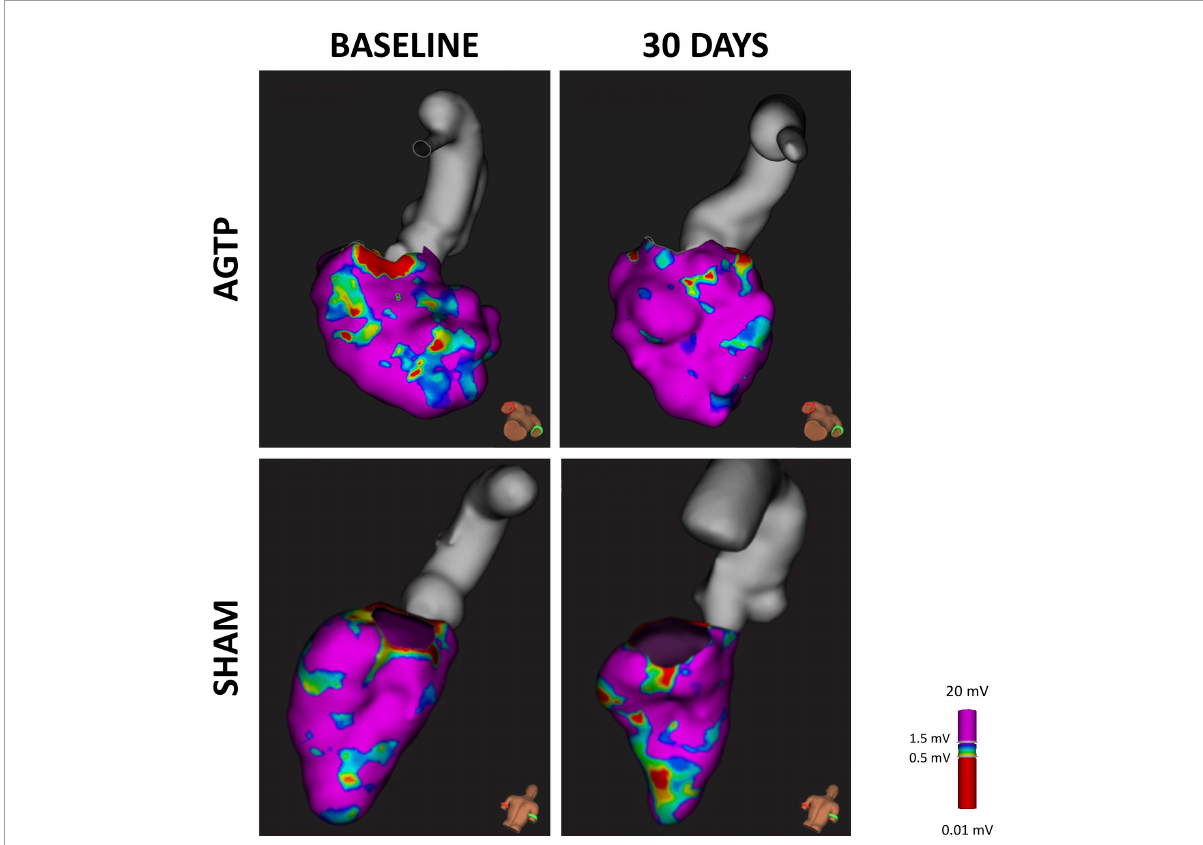
FIGURE4 Scar detection by endocardial mapping. High density endocardial mapping of the left ventricle showing post-MI low voltage area. After 30 days, animals receiving AGTP showed a reduction in border zone area (0.5–1 mV) (upper panel) whereas those in the Sham group showed overall increase in total scar area (bottom panel) .